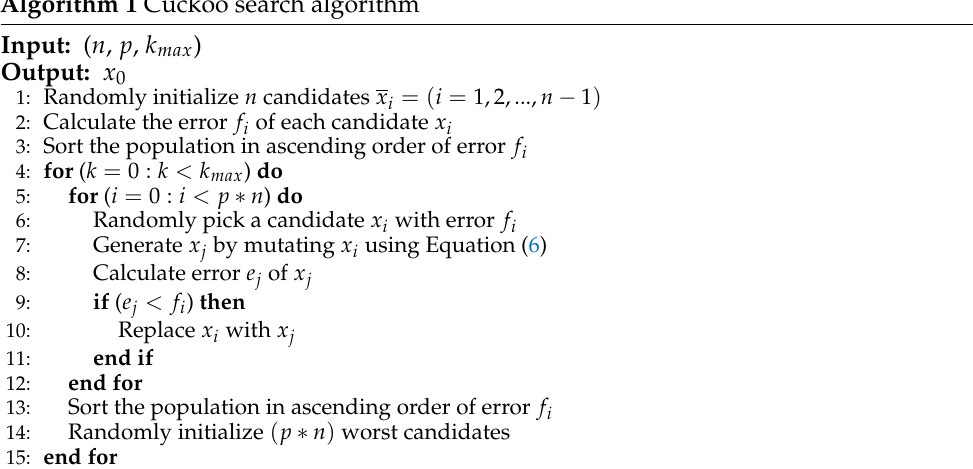
Algorithm 1 Cuckoo search